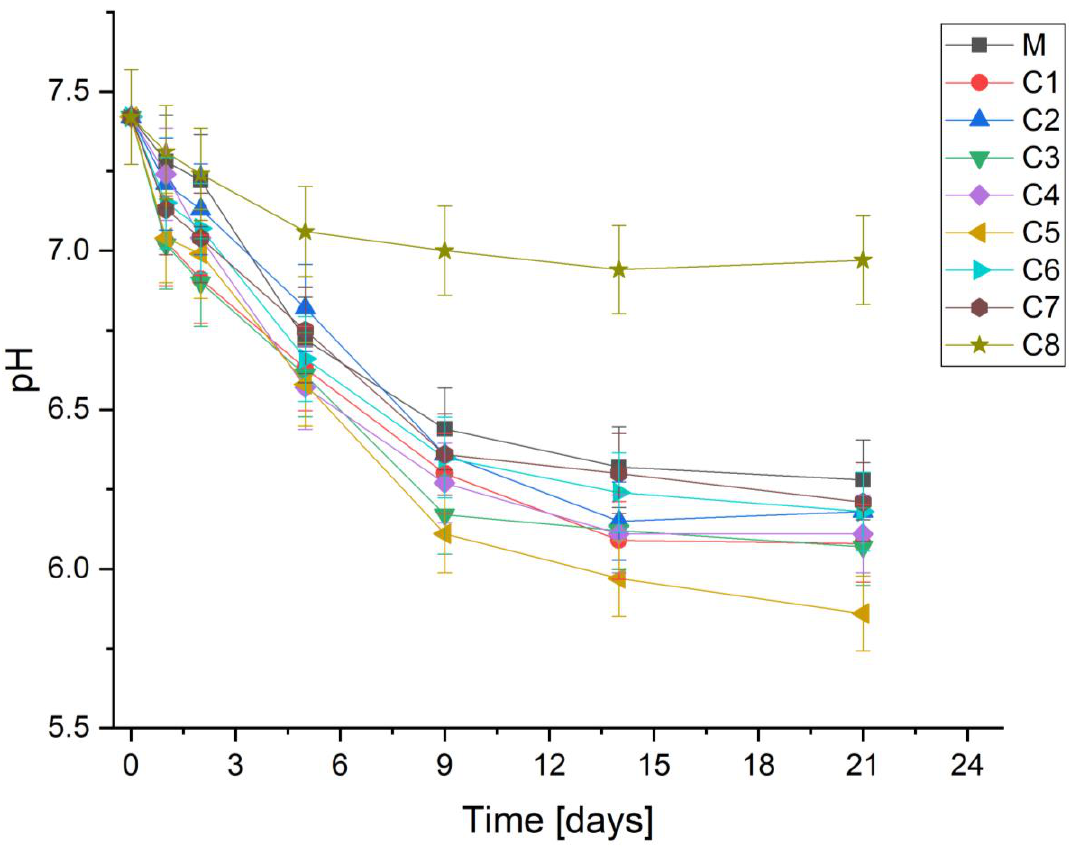
Figure 3. pH variation of PBS without-soaking time for CaF–P 2 O 5 –CaO system containing various CuO.